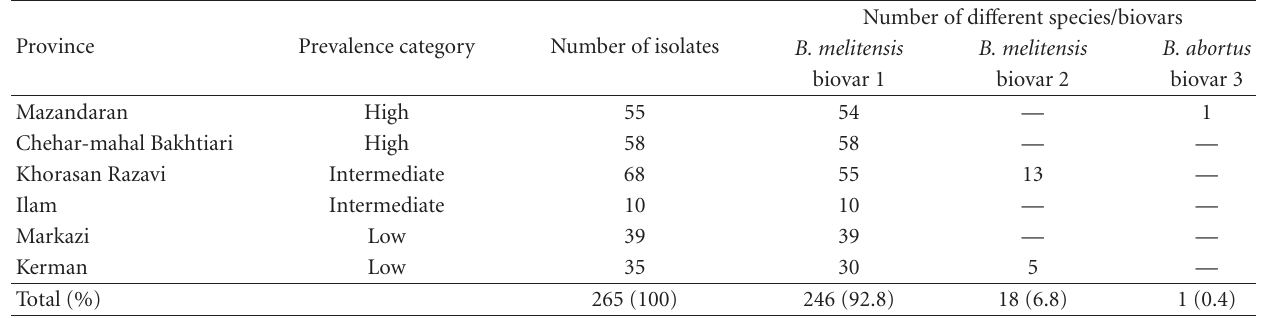
Table 1: Number of isolates in di ff erent provinces.